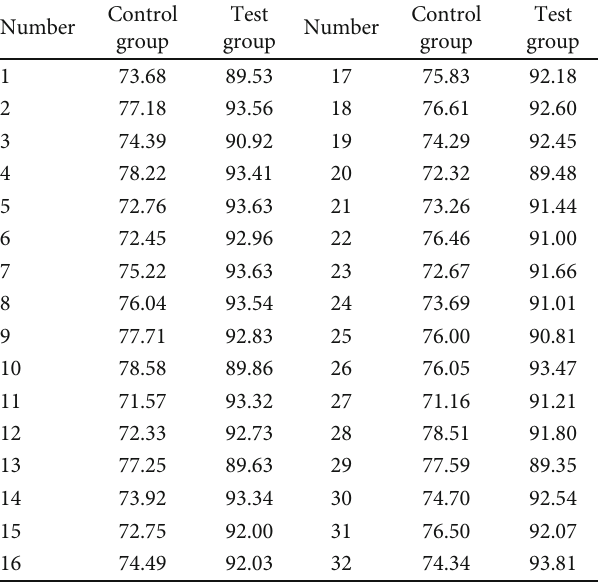
Table 5: Safety evaluation of treatment